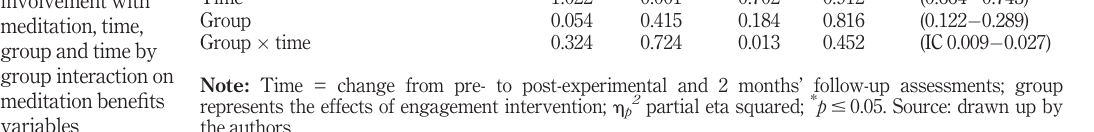
Table 3. Effects of